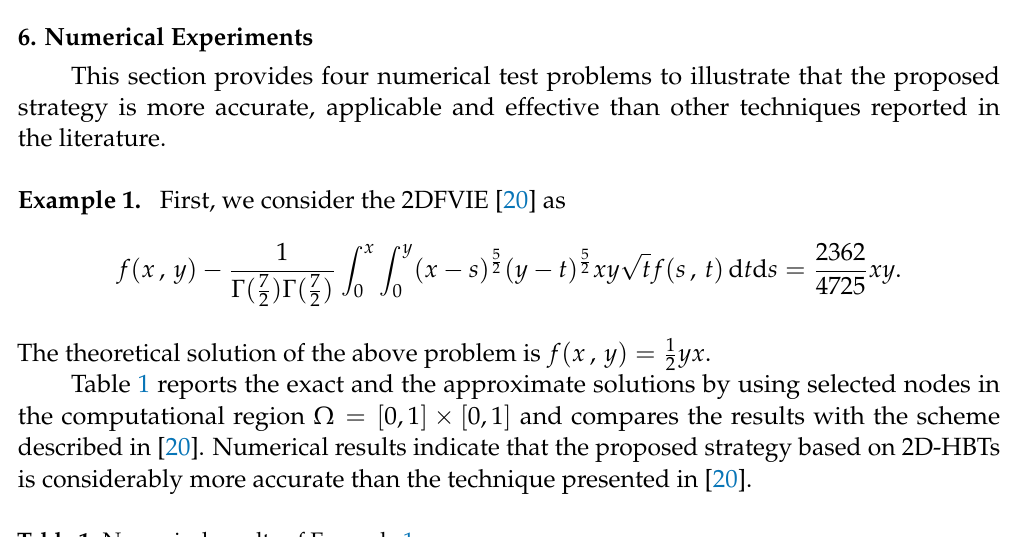
Table 1. Numerical results of Example